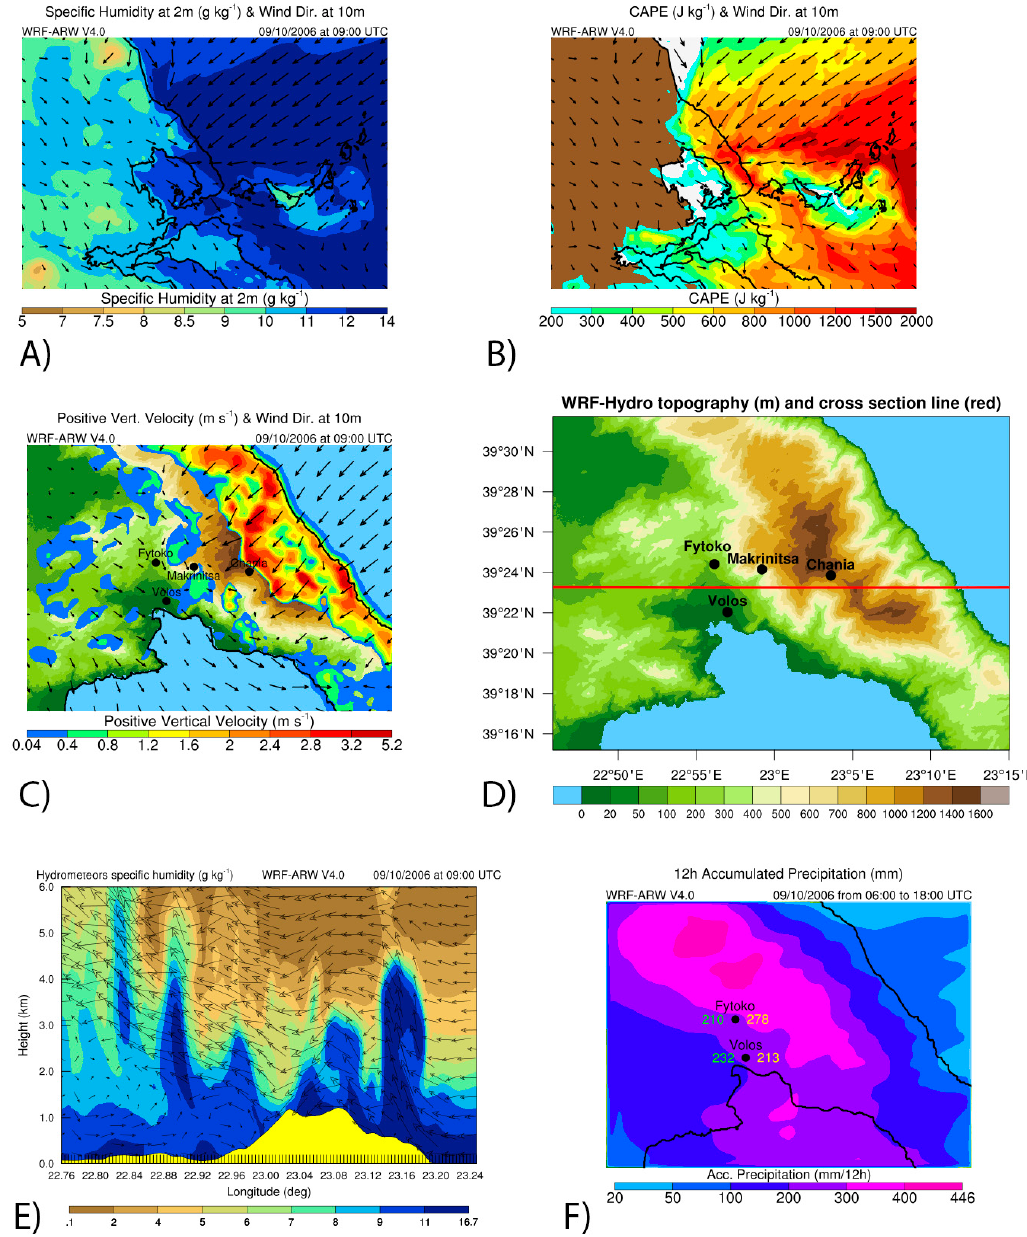
Figure 6. ( A ) Specific humidity (g kg − 1 ) at 2 m and horizontal wind vectors at 10 m and ( B ) convective available potential energy (J kg − 1 ) and horizontal wind vectors at 10 m based on WRF-ARW simulation results obtained from the fourth nested domain. ( C ) Positive vertical velocity (m s − 1 ) and horizontal wind vectors at 10 m based on WRF-ARW simulation results obtained from the fifth nested domain. ( D ) Topography map of the fifth nested domain, illustrating the vertical cross-section area (red line). ( E ) Vertical cross-section up to 6 km for hydrometeors specific humidity (g kg − 1 ) and wind vectors and ( F ) 12-h accumulated precipitation (mm) from 06:00 to 18:00 UTC on 9 October 2006 based on WRF-ARW simulation results obtained from the fifth nested domain. The measured and simulated accumulated precipitation values in Fytoko and Volos city are illustrated with green and yellow colours, respectively. The maps ( A – C , E ) refer to 9 October 2006 at 09:00 UTC.